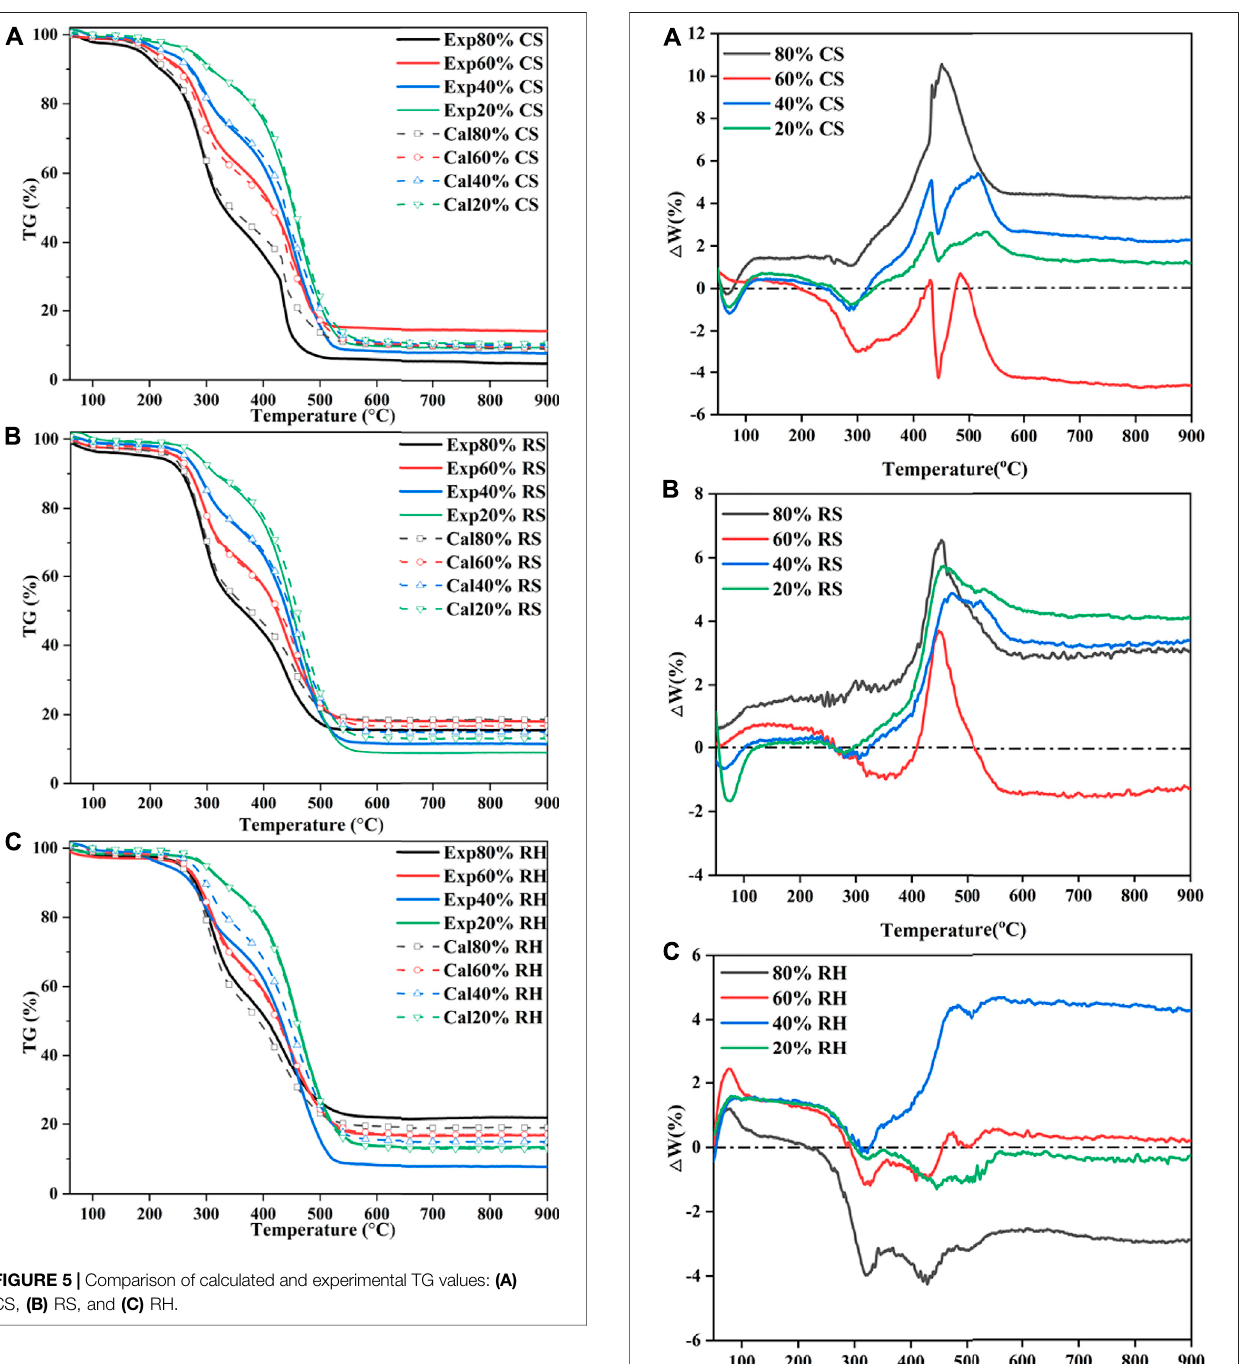
Frontiers in Energy Research |